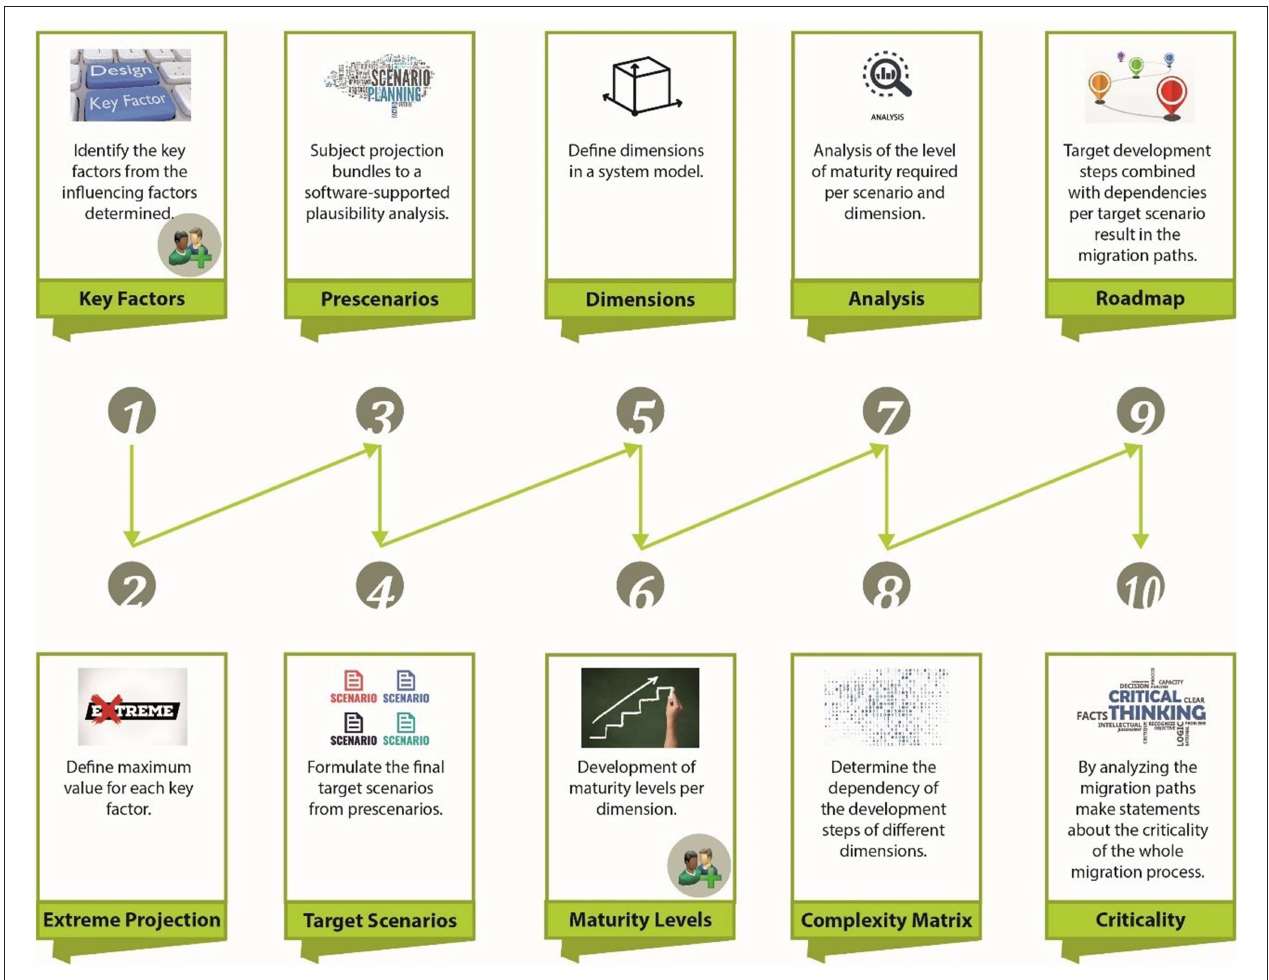
FIGURE 1 | Methodological approach for the development of Migration Paths (source: own illustration).